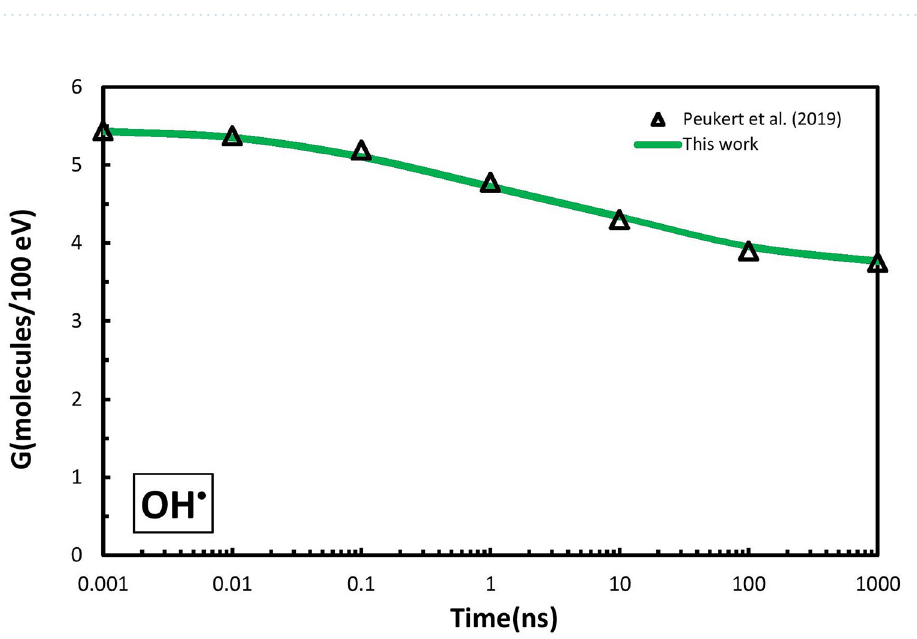
Figure 2. Simulation validation: comparison between the results of our simulation and the simulation by Peukert et al. 14 for time-dependent G-value of hydroxyl radical around the GNP for 50-MeV proton